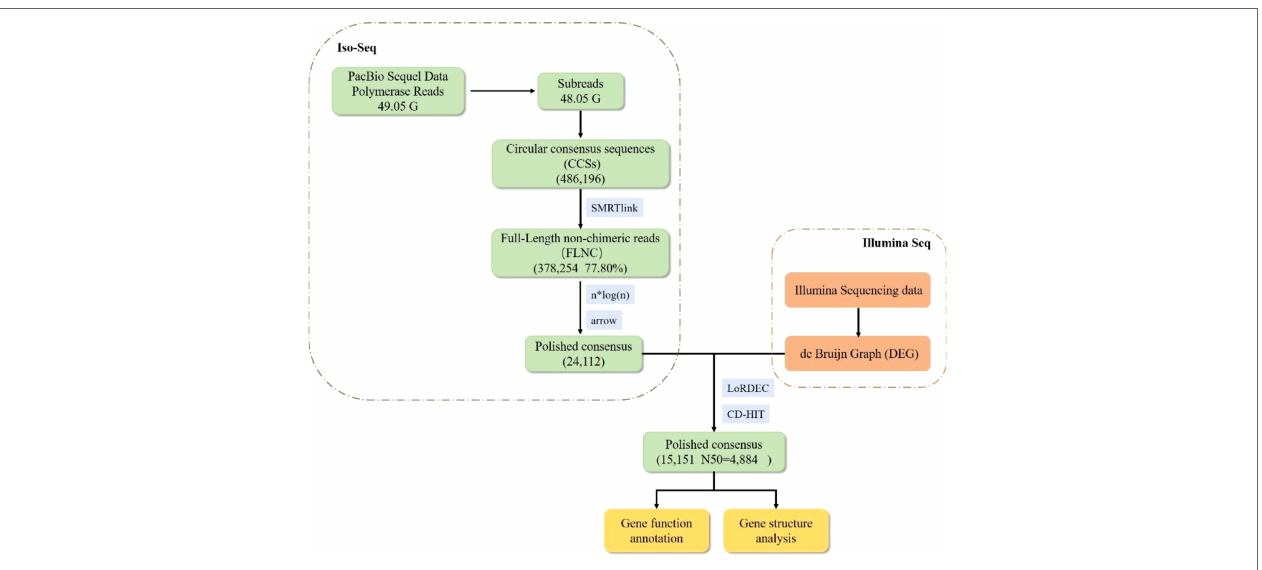
FIGURE 2 | The process and characteristics of Iso-Sequencing